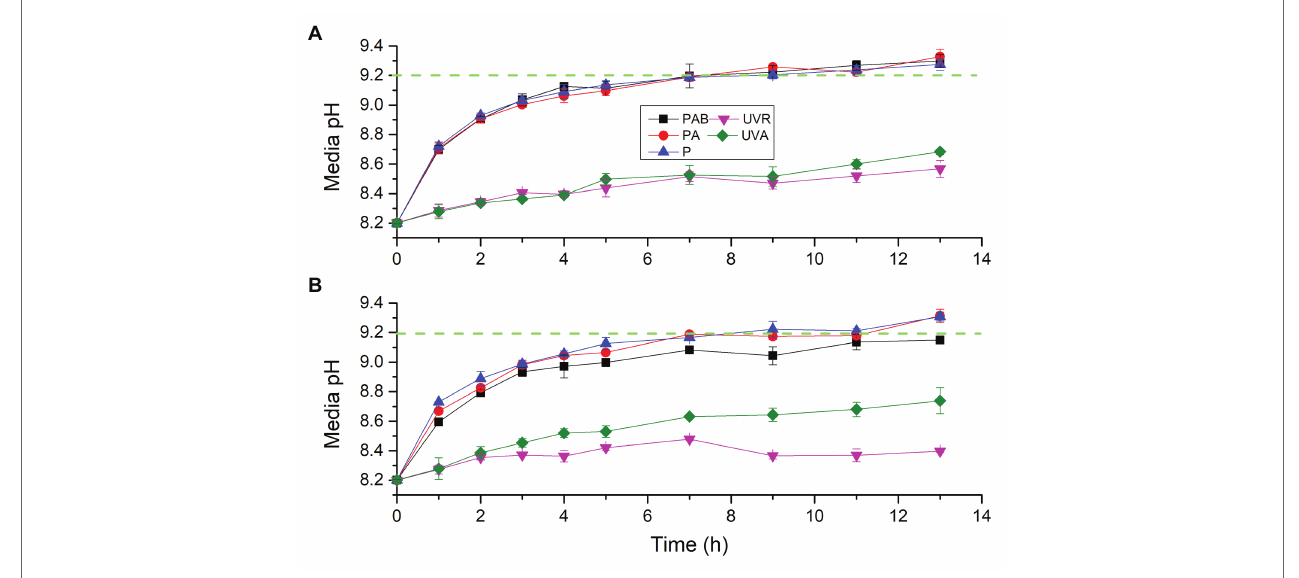
FIGURE 3 | Changes of pH in a closed system driven by photosynthesis of S. costatum exposed to different light treatments. The initial pH was 8.20. The low (A) and high (B) density levels are 51.84 and 172.80 W m −2 for PAR, 12.96 and 43.20 W m −2 for UVA, and 13.53 and 45.09 W m −2 for UVR (UVA + UVB), respectively. The error bars indicate the SDs ( n = 3). The dash line represents the pH compensation point above which indicates active HCO 3− uptake.